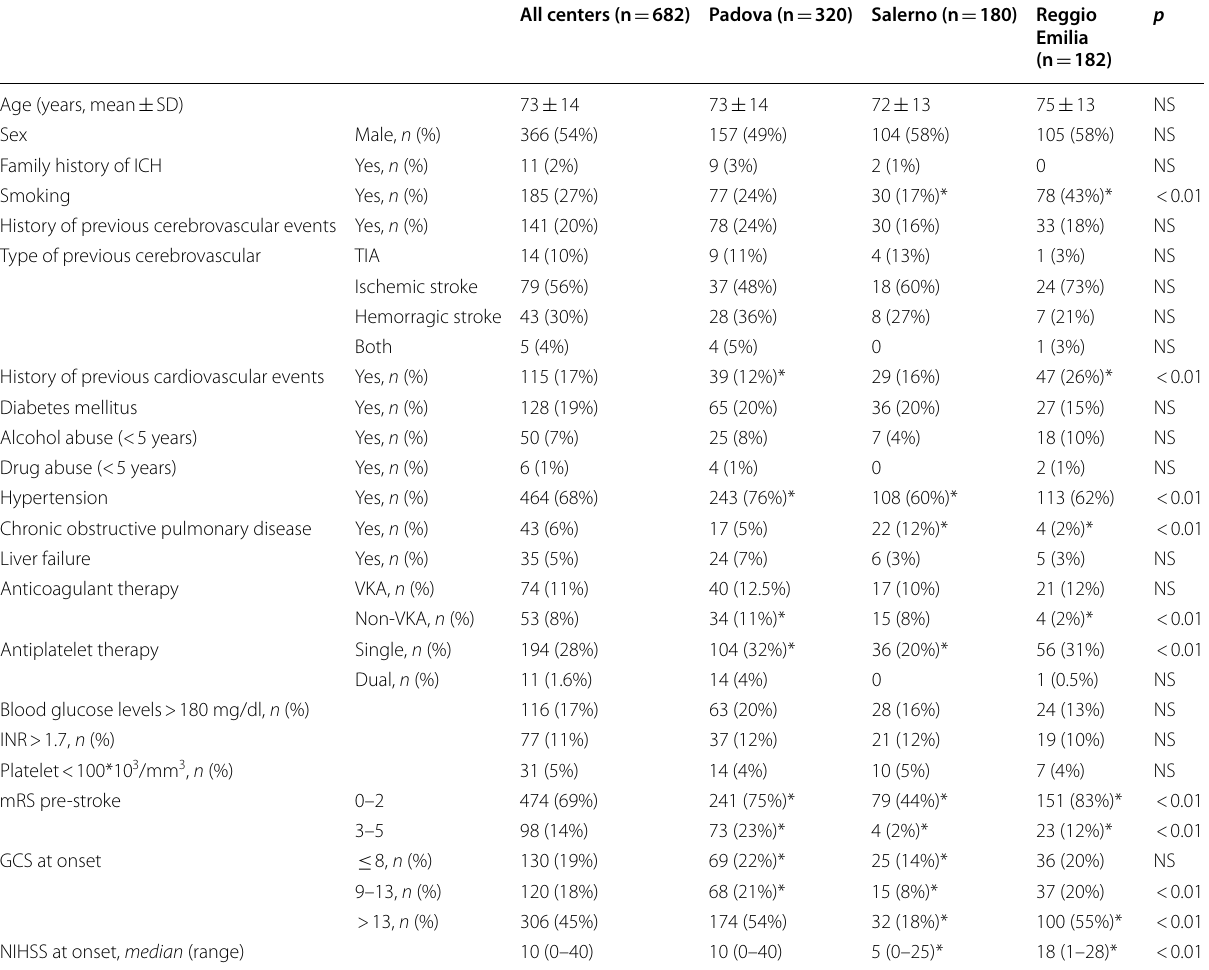
Asterisk denotes values that significantly differ from each other ICH intracerebral hemorrhage, TIA transitory ischemic attack, INR International Normalized Ratio, mRS modified Rankin Scale, GCS Glasgow Coma Scale, NIHSS National Institute of Health Stroke